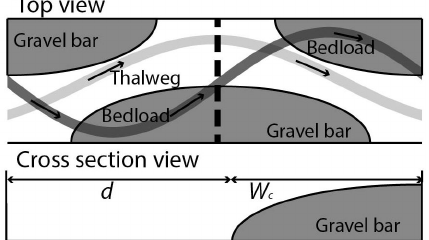
Figure 3. Top: schematic drawing of the top view of the channel with alternating gravel bars (dark grey), thalweg and main water pathway (light grey), and main bedload path way (transparent dark grey) after Bunte et al. (2006). Uncovered bedrock is depicted in white. Bottom: cross section across the centre of a bar (dashed black line in the top view), where the bedload path crosses from the bar into the uncovered channel. This cross section is relevant for setting the reach-scale channel width, since the sideward deflection of bed- load particles toward the left-hand wall should be maximized (cf. Fig. 4). At steady state, the uncovered width within the cross sec- tion should be equal to the sideward deflection length scale d , and the relation d + W c = W should hold (cf. Fig. 1; Eq. 2).